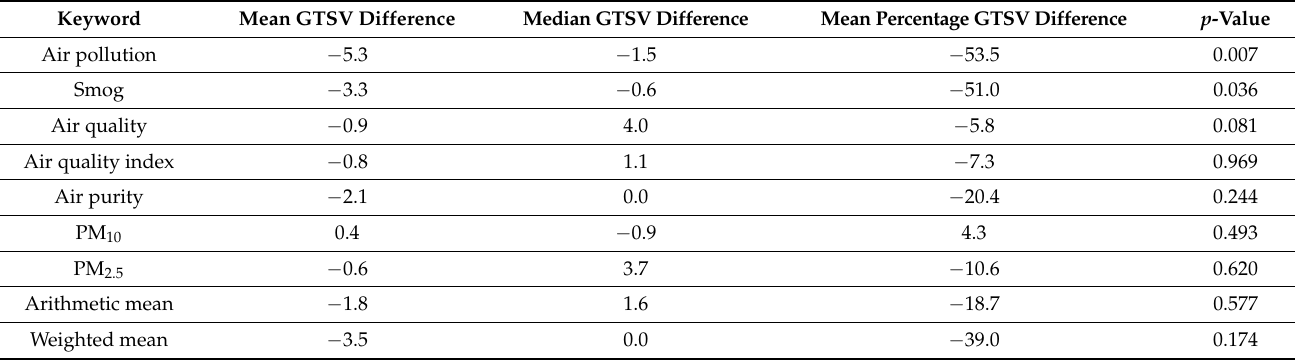
Table 2. Comparison of the real-world pre- and intra-pandemic